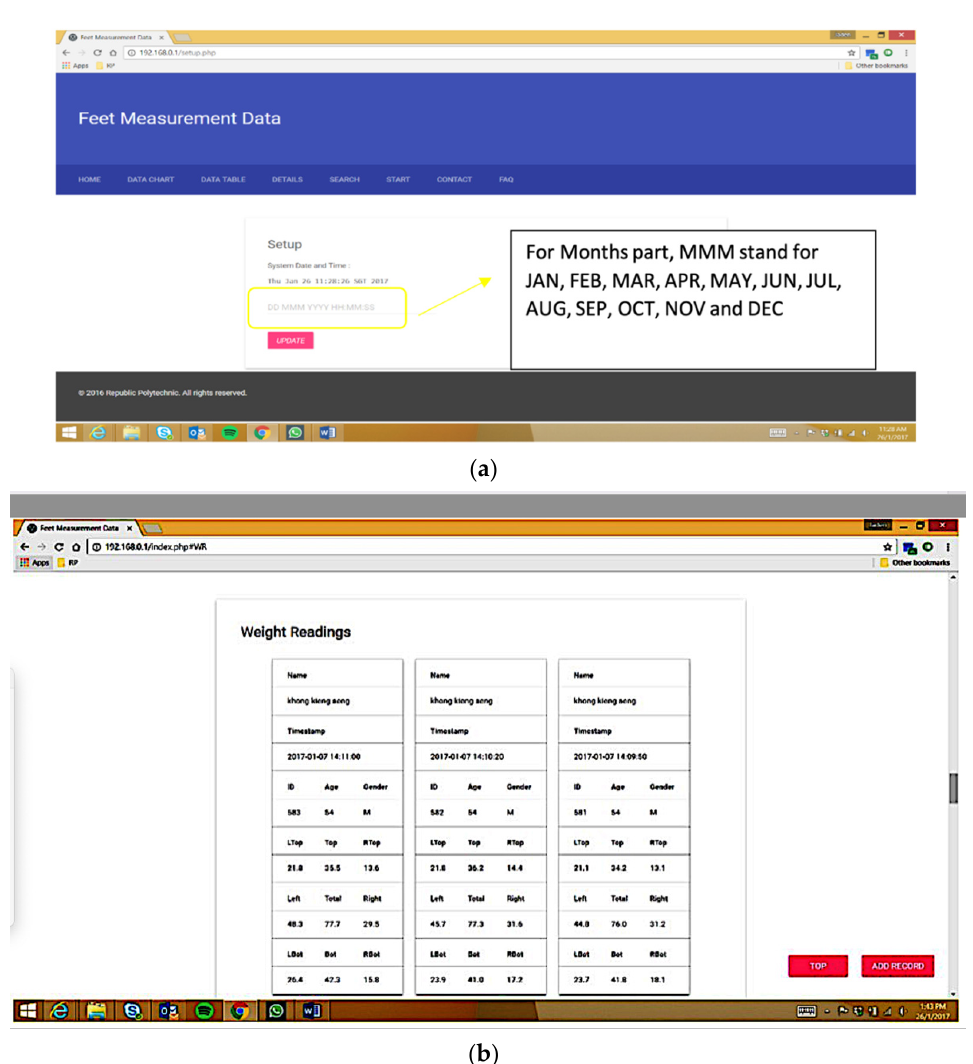
Figure 3. The website mode of ENP: ( a ) the Initiation and setup; ( b ) the Table page with multiple measurements to add.